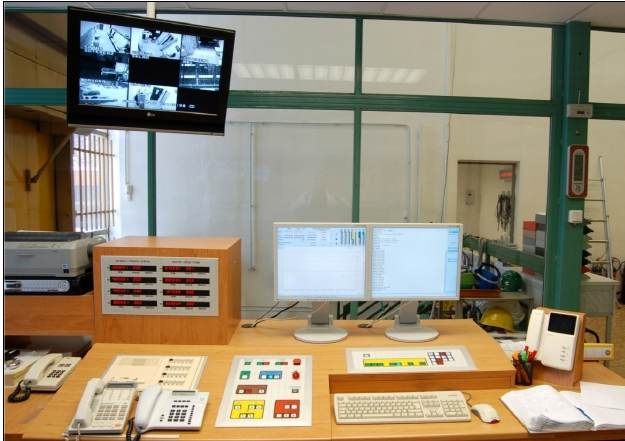
Fig. 1. Human-machine interface of the VR-1 reactor (before HMI desk upgrade in mid-2018)